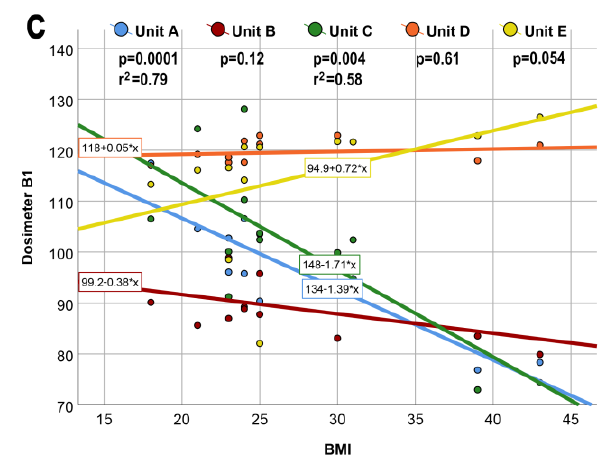
Figure 3. The figure shows how the irradiance of each treatment unit, measured by the H1 dosimeter, depends on the person’s height ( a ). The linear relation is significant, except for treatment unit E. The irradiance dependence on BMI is shown in ( b ) measured by dosimeter C1, and in ( c ) measured by dosimeter B1. The relation is only significant for unit A and unit C. r 2 values are given when relations are significant.